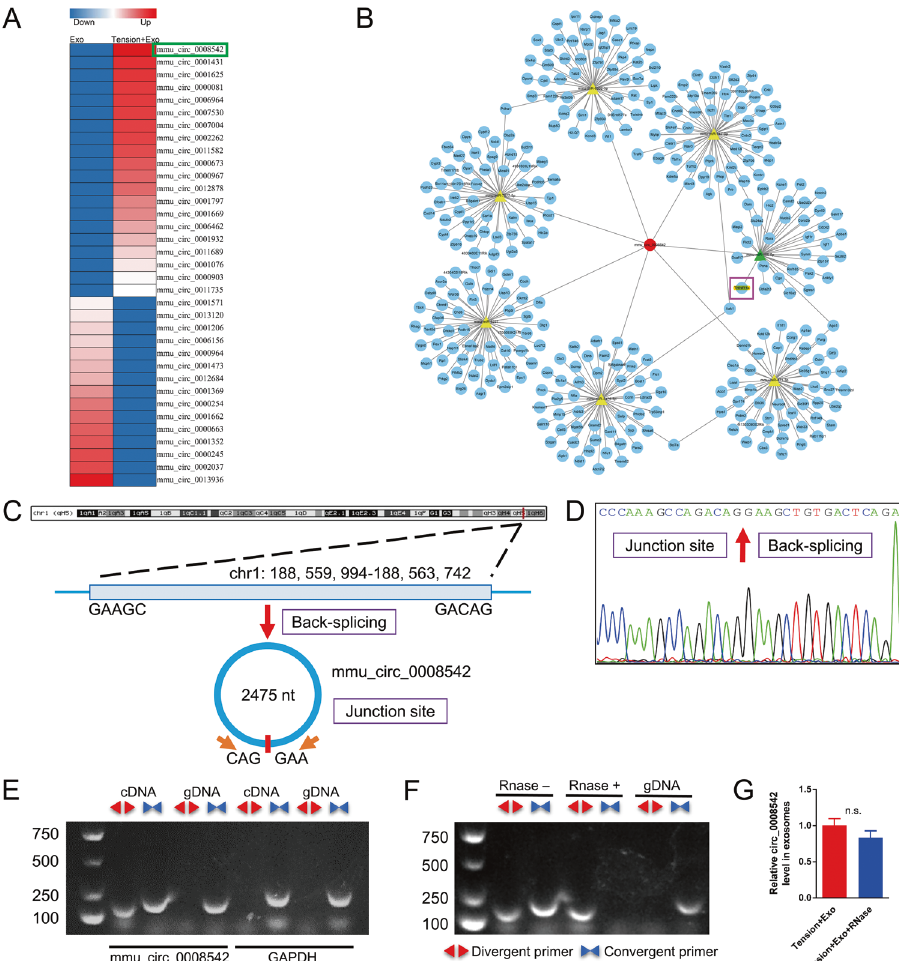
Fig. 1 Characterization of circ_0008542. A A heat map of different circRNAs between the two groups with or without tension stimulation. B Bioinformatics prediction of the circ_0008542/miRNA-185-5p-RANK axis. C Schematic diagram showing the genomic location and back- splicing pattern of circ_0008542. D Sanger sequencing of circ_0008542. The arrow shows the “ head-to-tail ” splicing site. E Divergent primers detected circ_0008542 from cDNA by PCR and agarose gel electrophoresis, rather than from gDNA. F Circ_0008542 from cDNA was ampli fi ed with divergent primers, even after treatment with RNase R digestion, and the opposite results were observed for gDNA. G Relative expression level of circ_0008542 in exosomes between two groups with or without RNase R digestion. Data were representative of three independent experiments expressed as the mean ± SD (* p < assay (Fig. 3G). RNA induced silencing complexes (RISCs) are formed by miRNA ribonucleoprotein complexes (miRNPs), which are present in anti-AGO2 immunoprecipitates. Therefore, anti- AGO2 immunoprecipitates contain miRNAs and their interacting compared to anti-IgG immunoprecipitates (Fig. 3H). RNA pulldown assay proved a signi fi cant enrichment of circ_0008542 in the